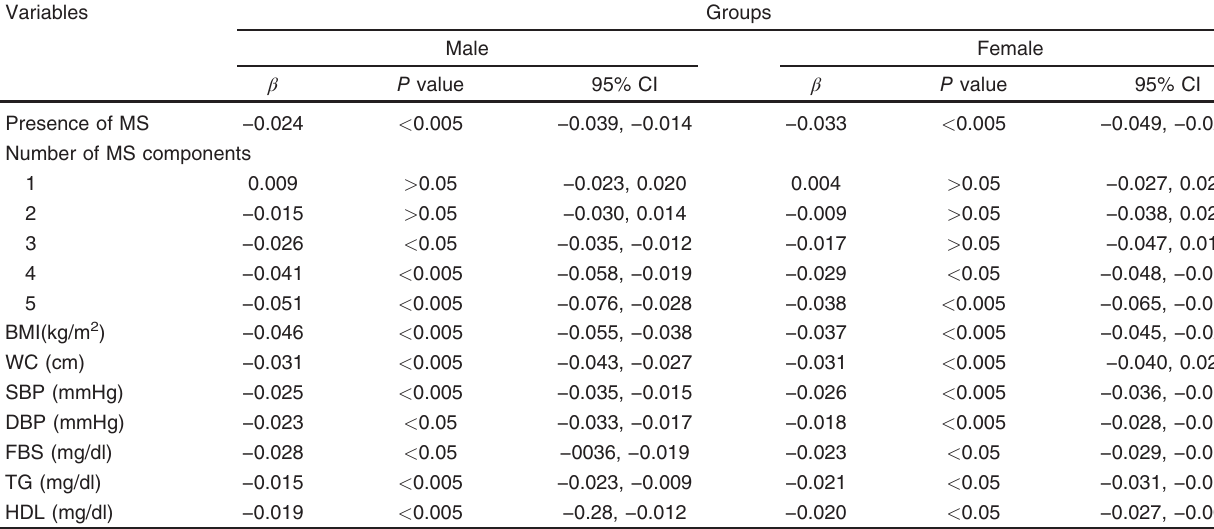
Table 7 Regression coefficients of the components of metabolic syndrome for forced expiratory volume in first second percent predicted Variables Groups